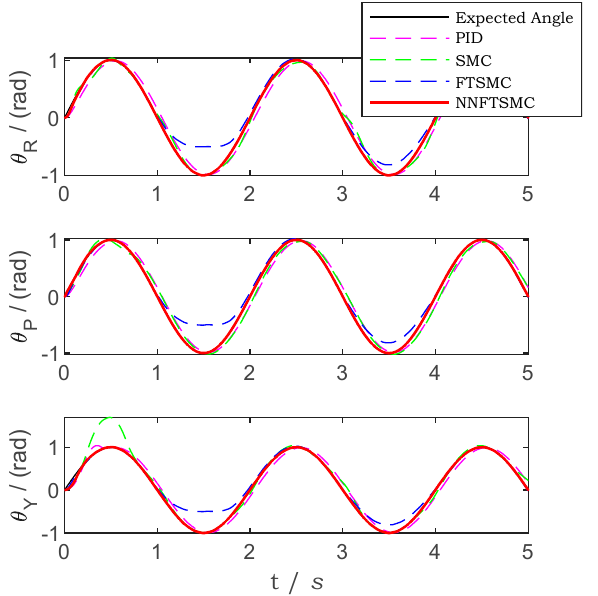
Figure 9. The attitude of the platform by using different controllers in the simulation of sine trajectory. Integral absolute error (IAE) and integrated square error (ISE) are important perfor- mance metrics to analyze the result of the control